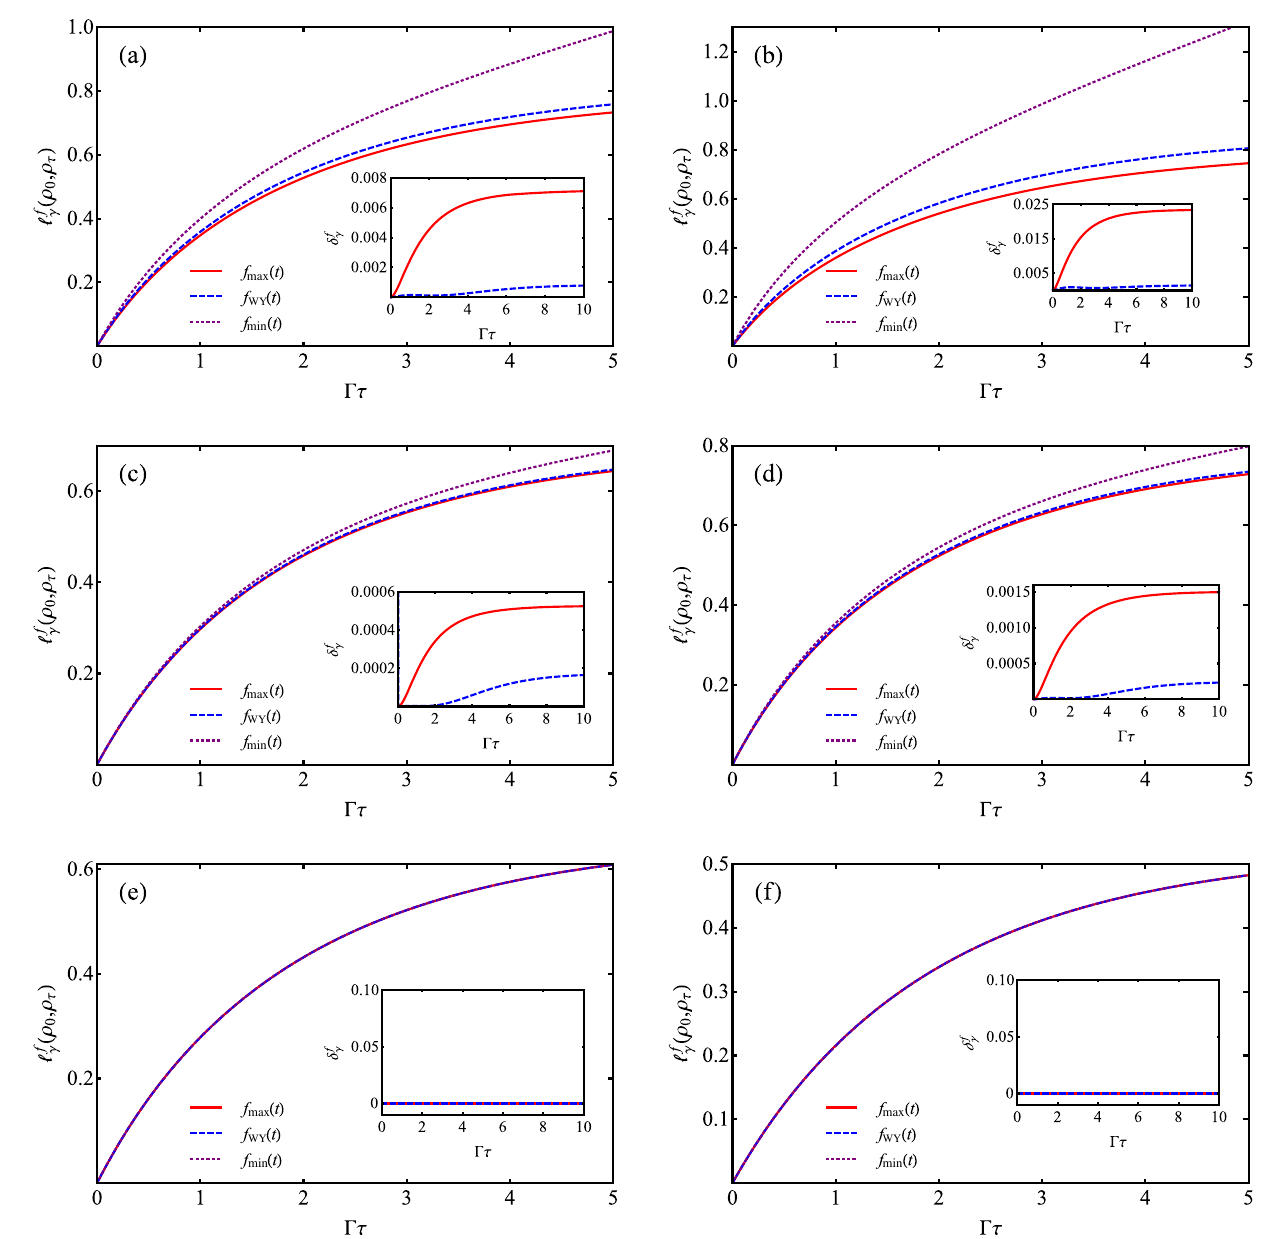
FIG. 6. Evolution path lengths l f γ for amplitude damping processes related to the contractive Riemannian metrics corresponding to the t Þ ¼ f t Þ (red solid line), f t Þ (blue dashed line), and f t Þ (purple dotted line) for (a) r 0 ¼ 1 = 2 , following MC functions: f QF ð max ð WY ð min ð θ π = 2 , (b) r 3 = 4 , θ π = 2 , (c) r 1 = 4 , θ π = 4 , (d) r 1 = 4 , θ π = 2 , (e) r 1 = 4 , θ 0 , and (f) r 1 = 2 , θ 0 . 0 ¼ 0 ¼ 0 ¼ 0 ¼ 0 ¼ 0 ¼ 0 ¼ 0 ¼ 0 ¼ 0 ¼ 0 ¼ The insets in each panel show the relative difference δ f γ , Eq. (19), for amplitude damping processes by considering the quantum Fisher information metric (red solid line) and the Wigner-Yanase information metric (blue dashed line); such a relative difference can be regarded as an indicator of the tightness of the bounds (the smaller δ f γ , the tighter the